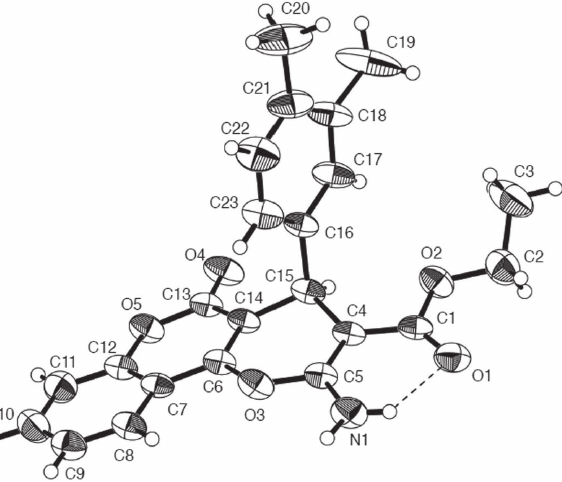
Table 1: Data collection and handling.